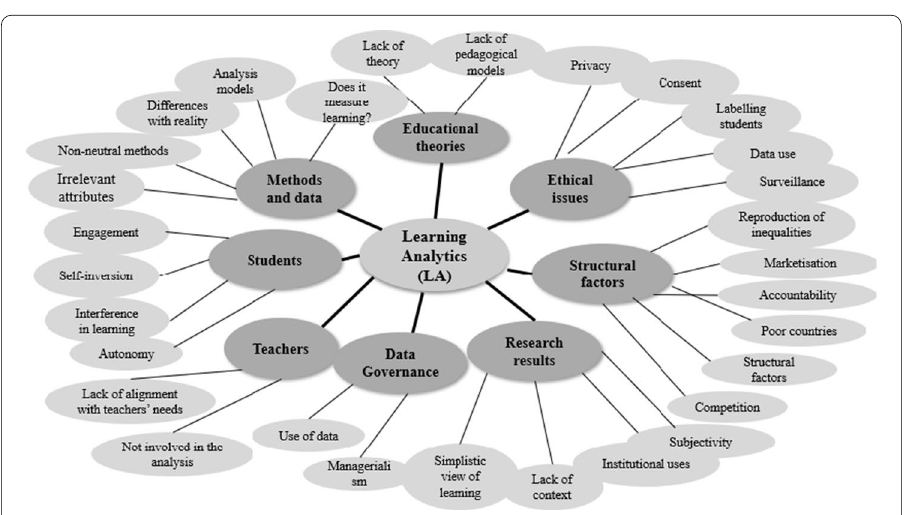
Fig. 2 Critical issues and challenges for learning analytics. Own